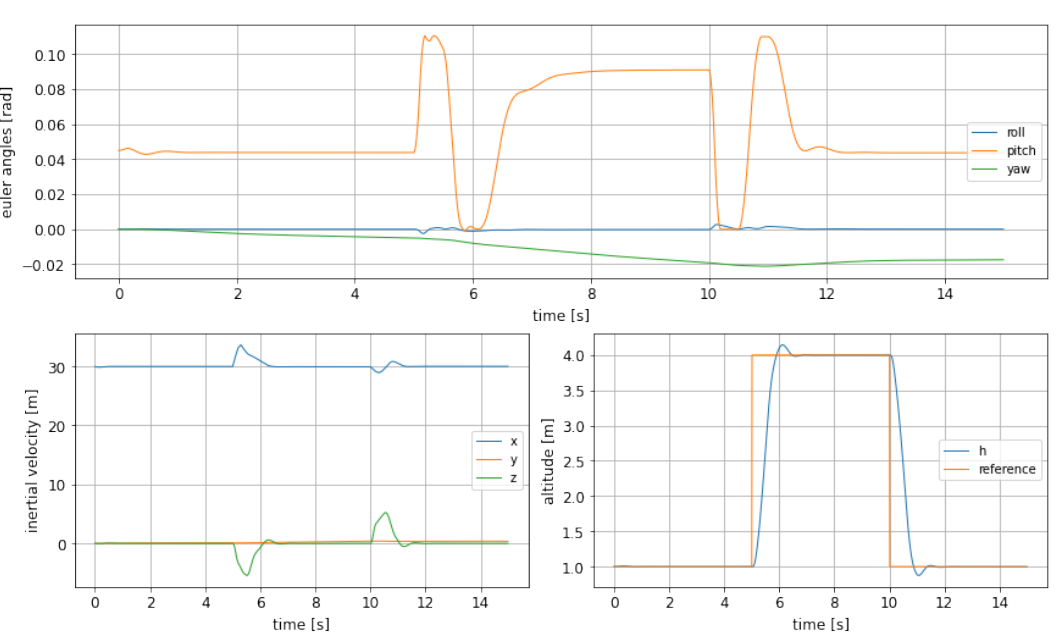
Figure 4. Euler angles ( top ), inertial velocities ( bottom left ) and altitude change ( bottom right ) with MPC, using the 3 control surfaces from